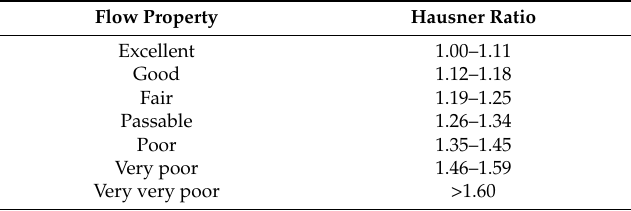
Table 2. Empirical relation between the flow properties of a granular material and its Hausner ratio